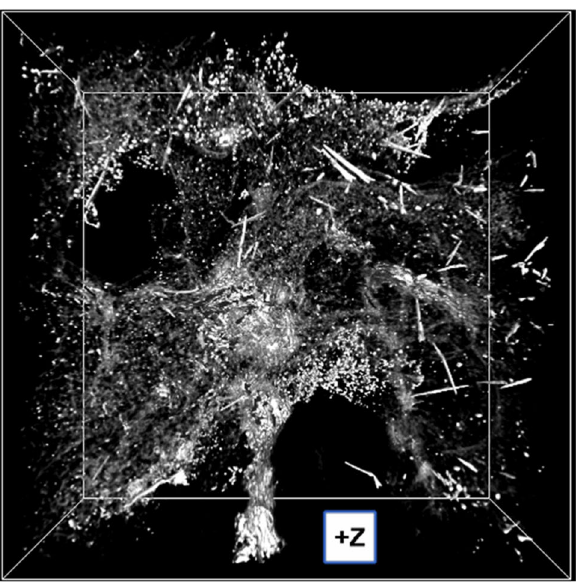
Figure 3. Perspective 3D view of a representative sub-volume of a lung tissue sample of size 0.495 × 0.495 × 0.132 mm 3 (X, Y, Z) acquired at the I13-2 beamline at the Diamond Light Source (UK) at 14.7 keV incident X-ray energy. The bounding box is shown. The size of the (isotropic) voxels is 0.332 × 0.332 × 0.332 µm 3